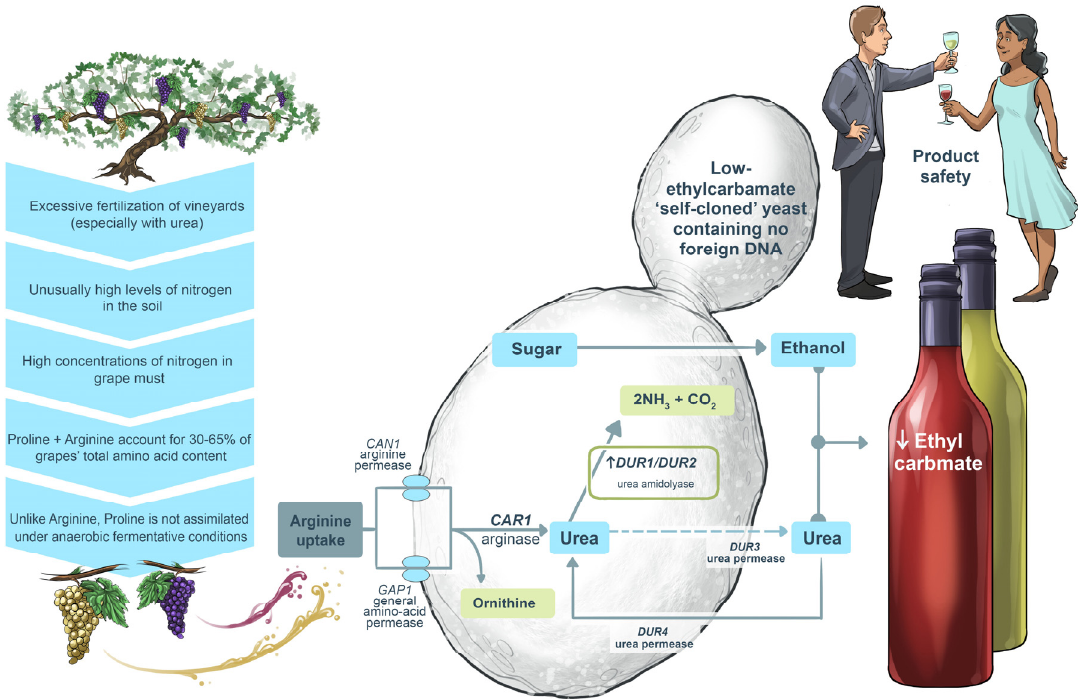
Figure 18. The construction of a wine strain of Saccharomyces cerevisiae that reduces the levels of ethyl carbamate formation during wine fermentation (adapted from [22,23]). A genetically modified wine yeast strain, Eco01, was commercialised and made available for commercial wine production in a few countries.